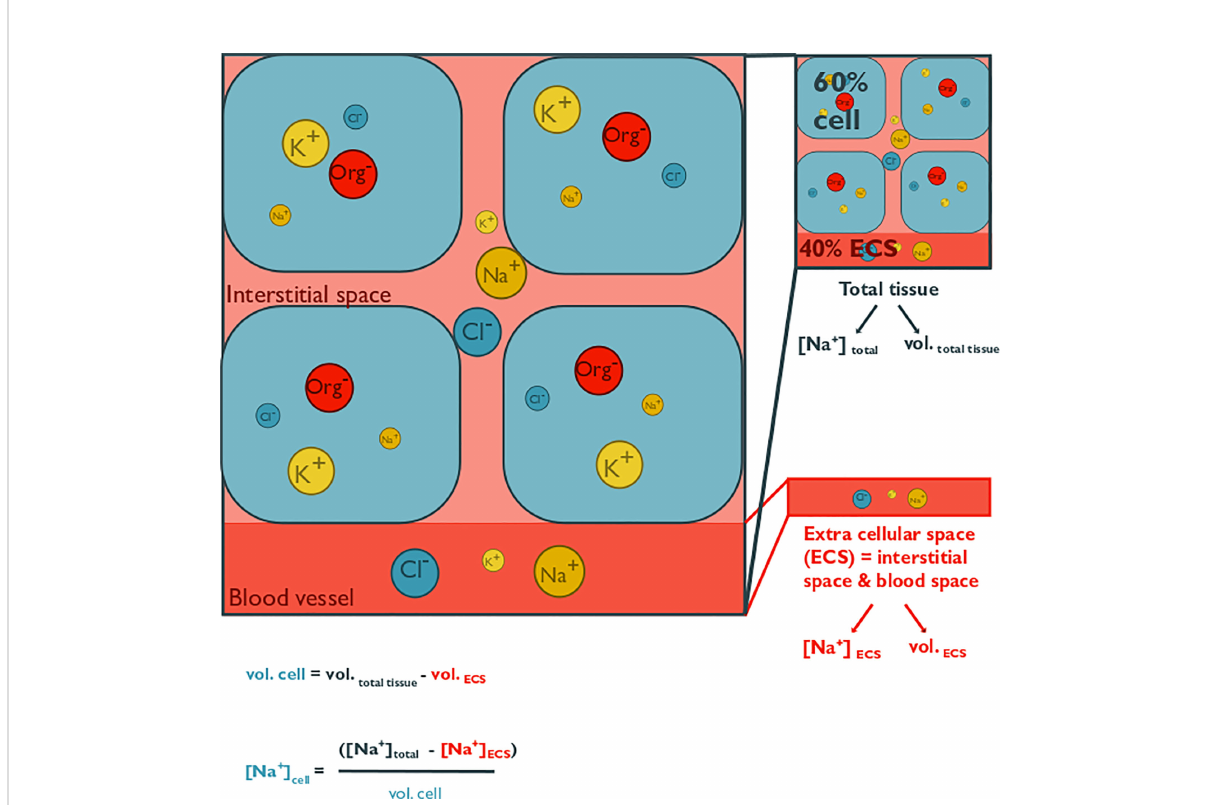
FIGURE 1 This conceptual fi gure shows the main components of cellular volume regulation in tissues and how intracellular solute concentrations can be estimated. It illustrates osmolyte concentrations in the extracellular space (ECS; consisting of interstitial space and blood, coelomic fl uid, or hemolymph space) and within cells of a generic tissue. Extracellular fl uid osmolality is modulated exclusively by inorganic osmolytes, whereas cells also utilize organic osmolytes. Only the major inorganic ions are depicted, namely chloride, potassium, and sodium. The abbreviation “ Org ” represents a variety of organic osmolytes, such as alanine, betaine, glycine, or taurine. The size of the circles represents the concentration of a speci fi c osmolyte. A total tissue sample can contain a large proportion of the ECS, which is on average 40%, with a range from 10% to 80% of tissue mass. Since the ion concentration in the ECS roughly represents that of the surrounding seawater and intracellular osmolality is partially accounted for by organic osmolytes, intracellular inorganic ion concentrations are lower than those in the ECS. Measurements using tissue homogenates thus overestimate cellular inorganic osmolyte concentrations and underestimate organic concentrations, if they are not corrected for the ECS contribution. Extracellular ion concentration can be measured from blood, coelomic fl uid, or hemolymph samples. The ECS can be estimated via the dilution of a known volume of a radioactive, or fl uorescent tracer (such as 14 C-inulin, or FITC-inulin) that is injected into extracellular fl uid. Cell volume is estimated from the difference between tissue volume and ECS volume. Intracellular osmolyte concentration can then be calculated with the given formula, where vol. cell = cell volume, vol. ECS = ECS volume, vol. total = total tissue volume, [Na+] cell = intracellular sodium concentration, [Na+]ECS = ECS sodium concentration, [Na+]total = total tissue sodium